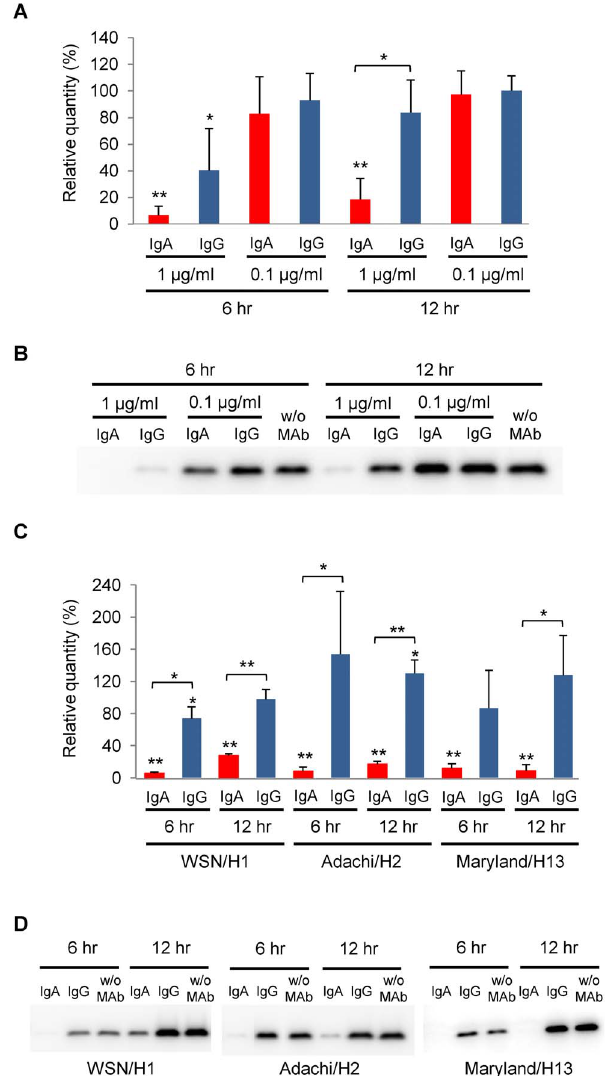
Figure 4. Viral release from infected cells cultured in the presence of S139/1 IgA or IgG antibodies. After inoculation with Aichi/H3 (A and B), WSN/H1, Adachi/H2, or Maryland/H13 (C and D), MDCK cells were cultured in the presence of S139/1 IgA or IgG antibodies at the concentrations of 1.0 or 0.1 m g/ml (A and B) and 1.0 m g/ml (C and D). Supernatants were collected 6 and 12 hours after infection, and viral proteins of influenza viruses released into the supernatants were detected by Western blotting (B and D). The relative quantity of the M1 protein was calculated based on the band intensity by using Image Lab version 3.0 (Bio-Rad) (A and C). The intensity of the M1 protein bands detected in the control supernatants collected from infected cells cultured without a MAb (w/o MAb) was set to 100%. Experiments were performed 3 times, and averages and standard deviations are shown (A and C). Statistical significance was analyzed by Student’s t-test (**p , 0.01, *p , 0.05). Asterisks placed directly above the bars indicate significant differences compared to respective controls, and asterisks placed between the bars show significant differences between S139/1 IgA and IgG